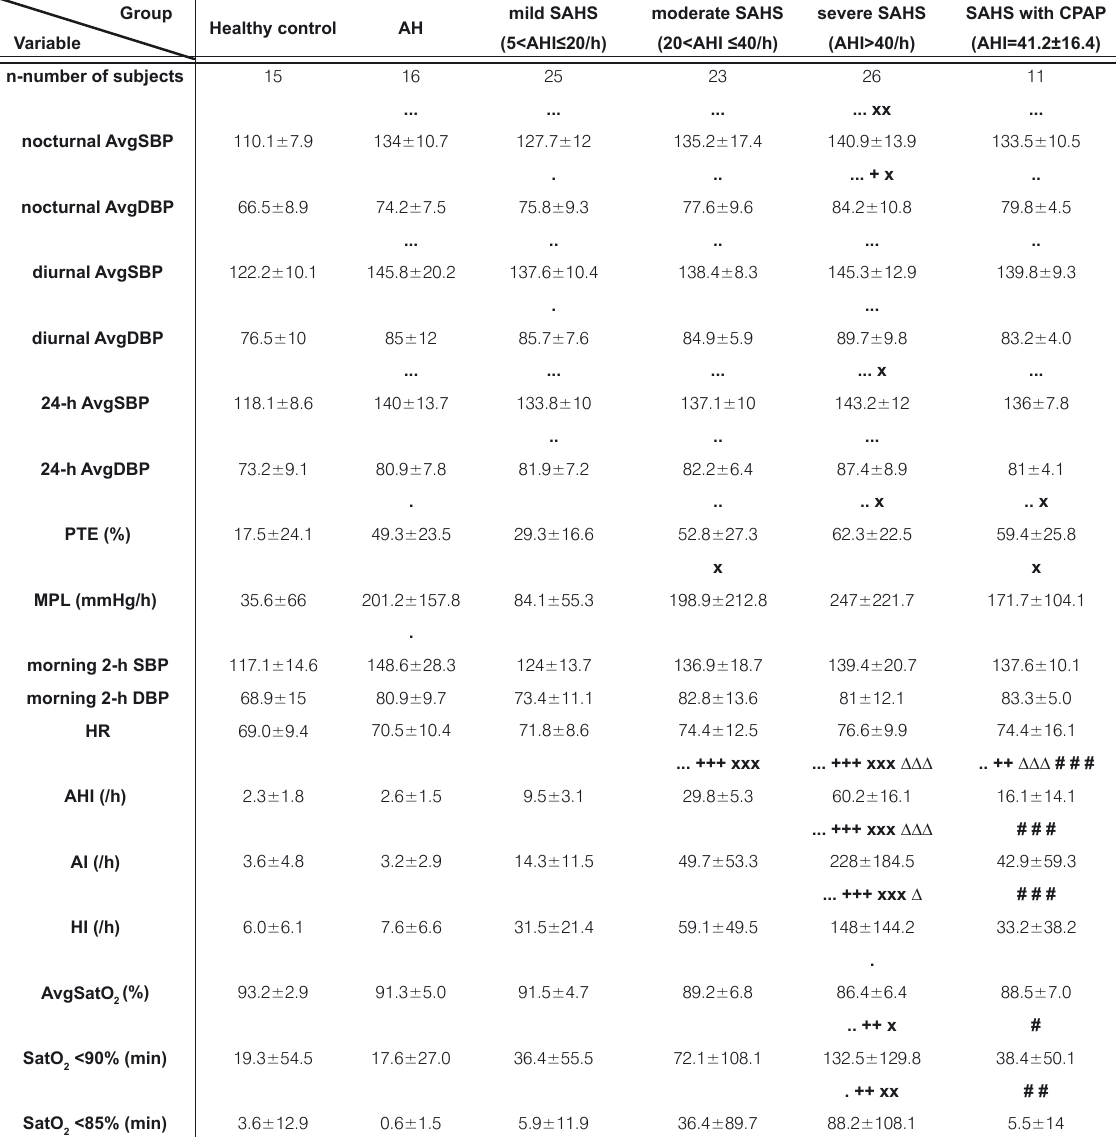
Table 2. Selected blood pressure and polysomnographic variables and indices in 6 groups of 116